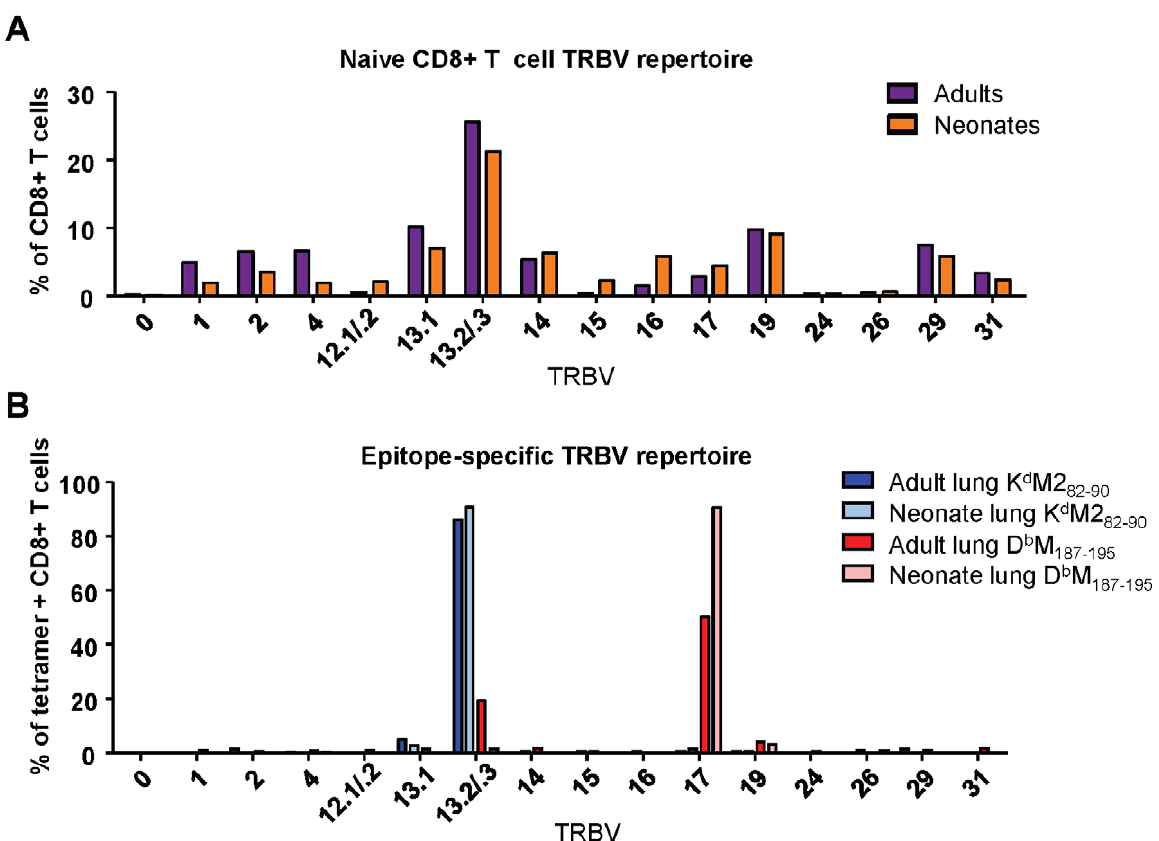
Figure 5. TCR V b screening of naı¨ve and epitope-specific CD8 + T cells in adult and neonatal mice. (A) TCR V b antibody screen of CD8 + T cells from the spleen of naı¨ve adult and naı¨ve neonatal CB6F1 mice. Samples were stained with surface phenotype antibodies, and a panel of FITC- labeled V b -specific antibodies. (B) TCR V b antibody screen of epitope-specific (K d M2 82-90 and D b M 187-195 ) CD8 + T cell populations in the lungs of RSV- infected adults and neonates. Lung lymphocytes were stained with surface phenotype antibodies, epitope-specific tetramer, and V b -specific antibodies. All TRBV regions are listed using IMGT nomenclature. Data represents two independent experiments performed with pooled naı¨ve splenic or lung